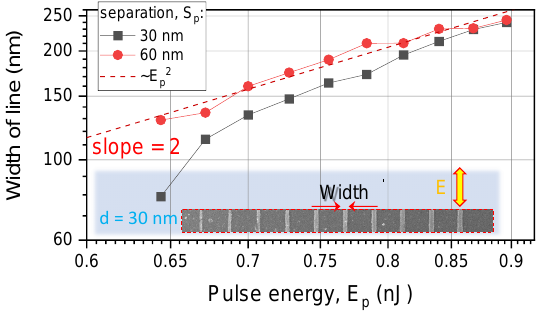
Figure 4. Plot showing the evolution of line-width vs. pulse energy E p for N = 10 pulses per site at different separations S p along the line (a log–log plot); polarisation of E-field was linear (along the line) shown in the inset. The trend of dependence closely follows a nonlinear ∝ E 2 p dependence.